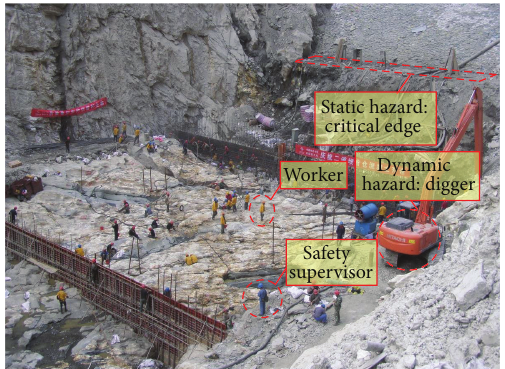
Figure 5: Monitored objects in terms of safety risk assessment on a typical hydropower construction